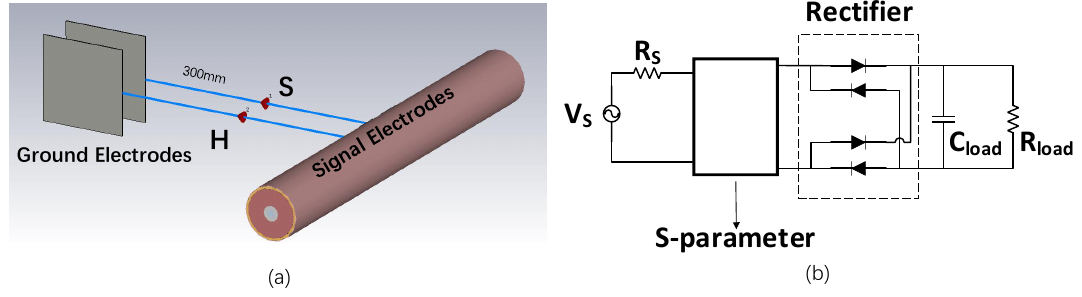
Figure 5. Co-simulation platform taking the SSSH case as an example. ( a ) Setup in CST. ( b ) Complete simulation circuits in Cadence [17].